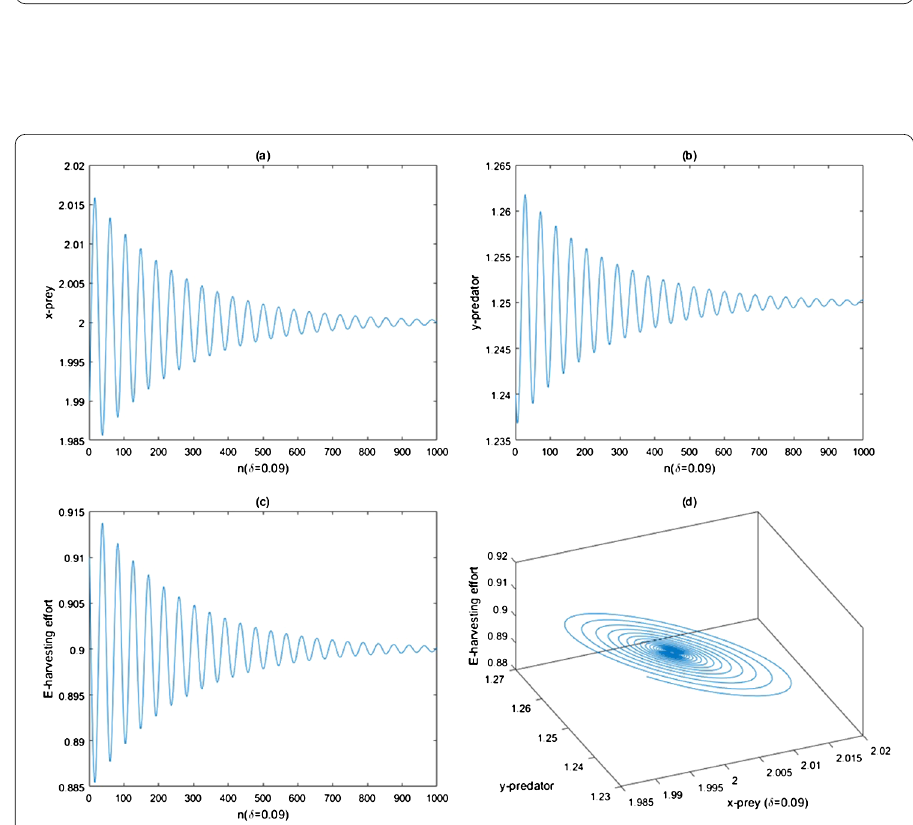
Figure 3 δ = δ 1 – 0.035, the fixed point (2,1.25,0.9) is a stable